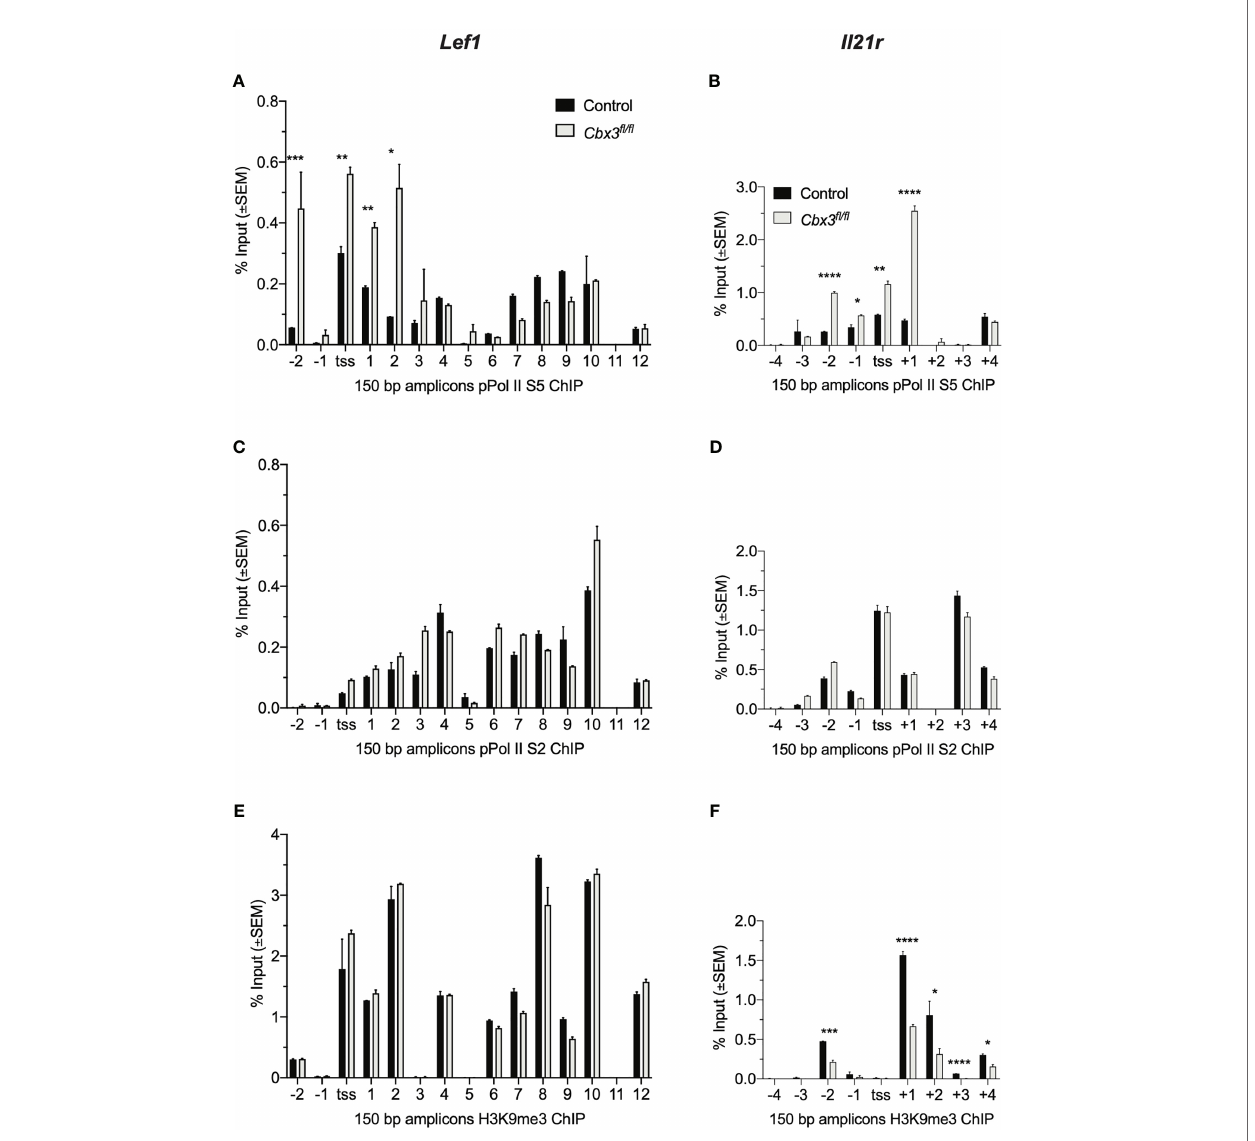
FIGURE 2 | Cbx3 /HP1 g regulates Lef1 and Il21r transcription initiation and chromatin remodeling. (A, B) Levels of Pol II S5 bound to Lef1 (A) and Il21r (B) were quanti fi ed by ChIP-qPCR using chromatin from day 5 activated/differentiated CD8 + T cells. TSS: transcription start site; numbers on X axis: positions of primers along the two loci; 150 bp products ampli fi ed by Lef1 or Il21r primers. (C, D) Levels of Pol II S2 bound to Lef1 (C) and Il21r (D) were quanti fi ed as in (A, B) . (E, F) H3K9me3 deposition on Lef1 (E) and Il21r (F) was quanti fi ed as in (A, B) . Graphpad unpaired student t-test: *p ≤ 0.05, **p ≤ 0.01, ***p ≤ 0.001, ****p ≤ 0.0001; representative of 4 independent ChIPs using pooled chromatin from 3